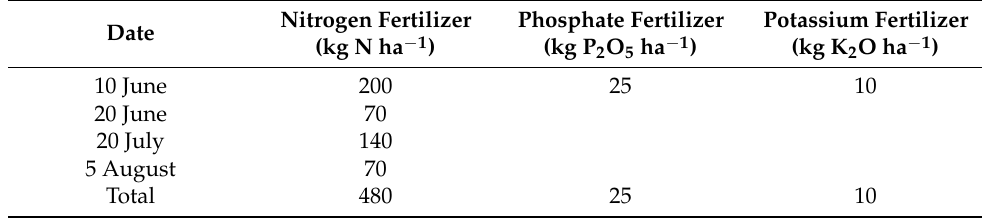
Table 2. Time and amount of